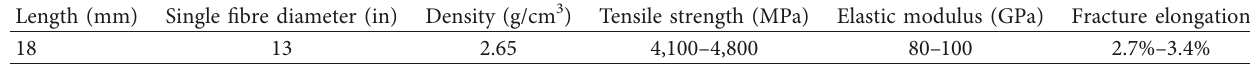
Table 1: Basalt fibre parameters.